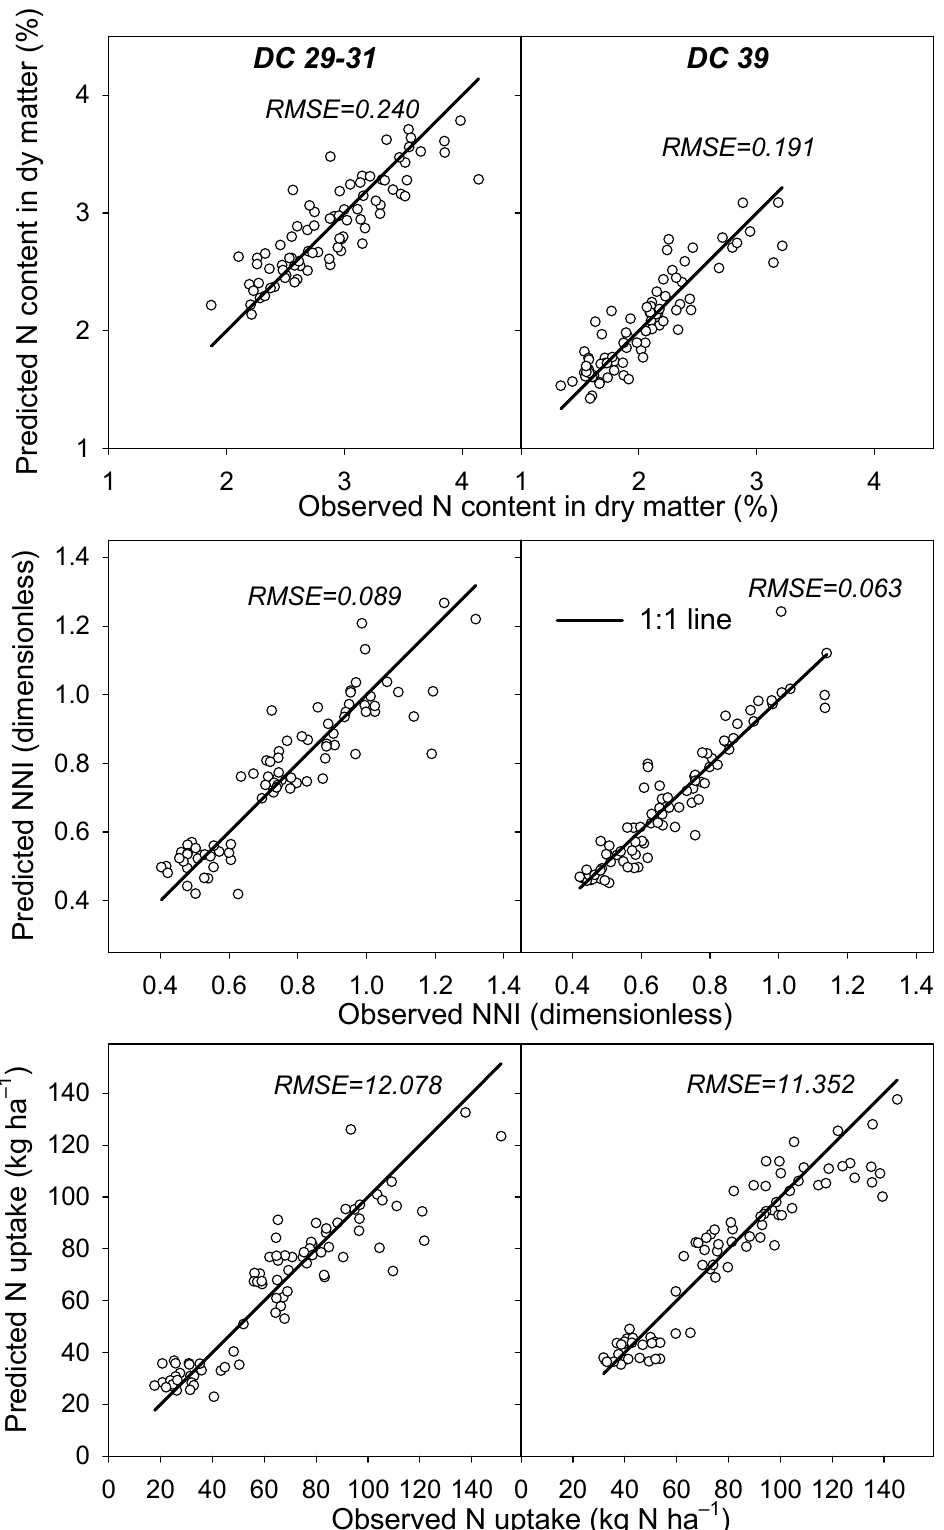
Figure 6. Comparison of observed nitrogen content in aboveground dry mass ( upper ), nitrogen nutrition index (NNI, middle ), and nitrogen uptake by aboveground biomass per area unit ( lower ) with predicted values by winning artificial neural networks. The 1:1 lines are plotted to evaluate deviations from observed data. Root mean square errors (RMSE) are indicated for each predicted set of data.